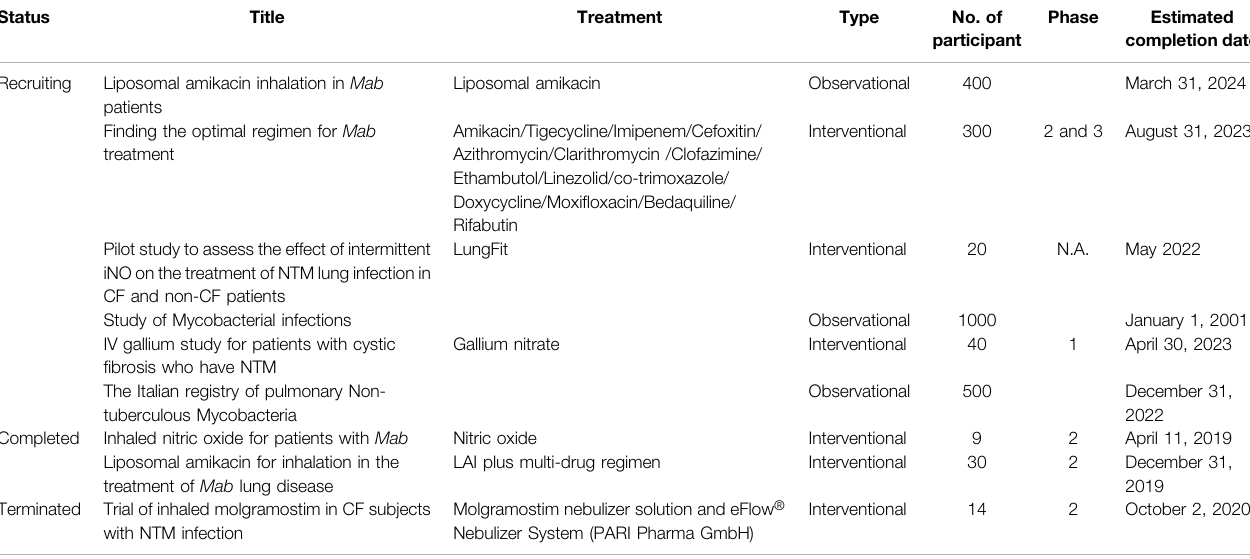
TABLE 1 | Current clinical trials evaluating regimens for Mab treatment